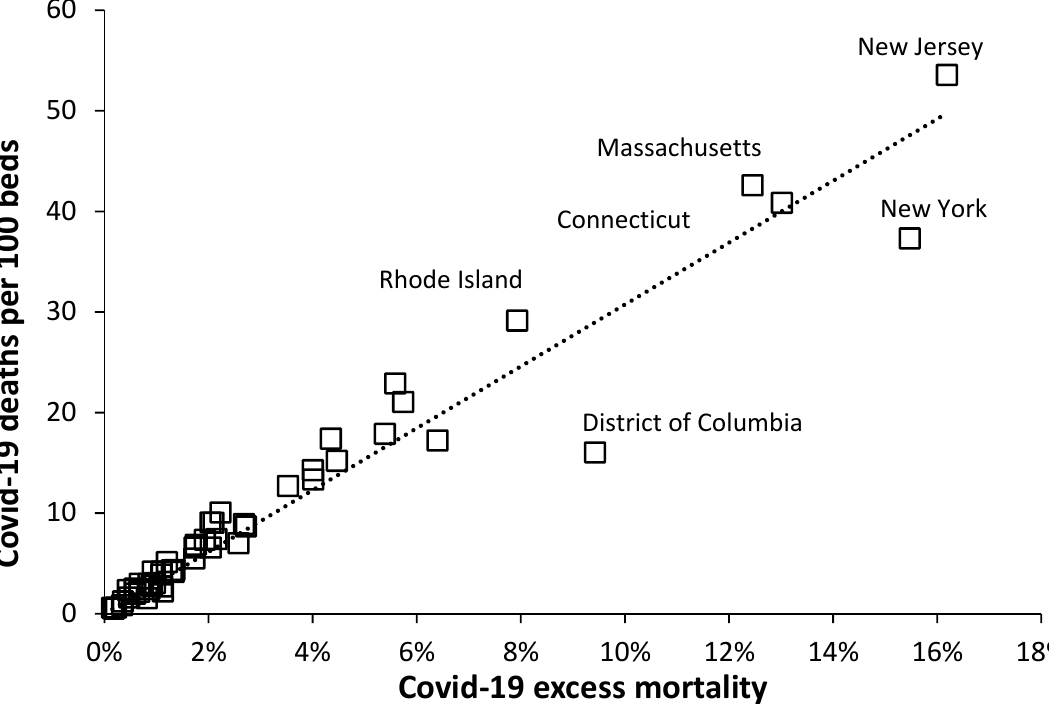
Figure 4. Covid-19 confirmed deaths per total hospital beds versus Covid-19 excess mortality relative to 2018 as the base year.